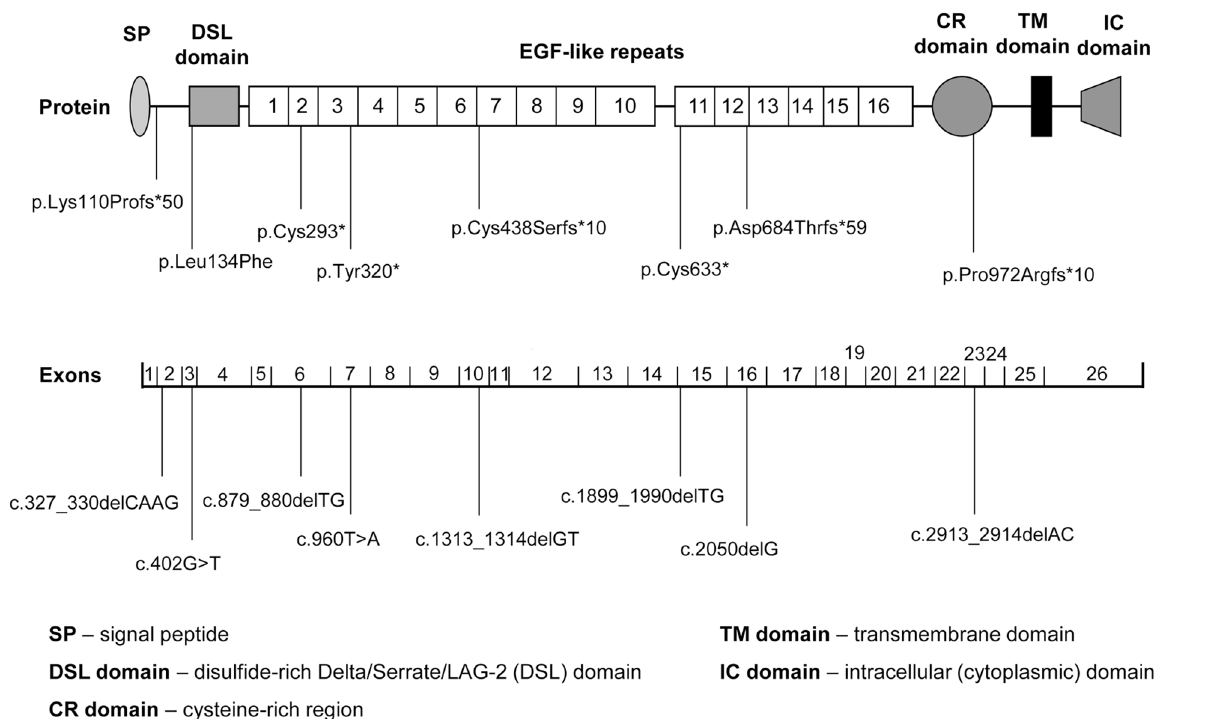
Fig 1. Schematic representation of the Jagged1 protein and spliced JAG1 mRNA with mutations found in our